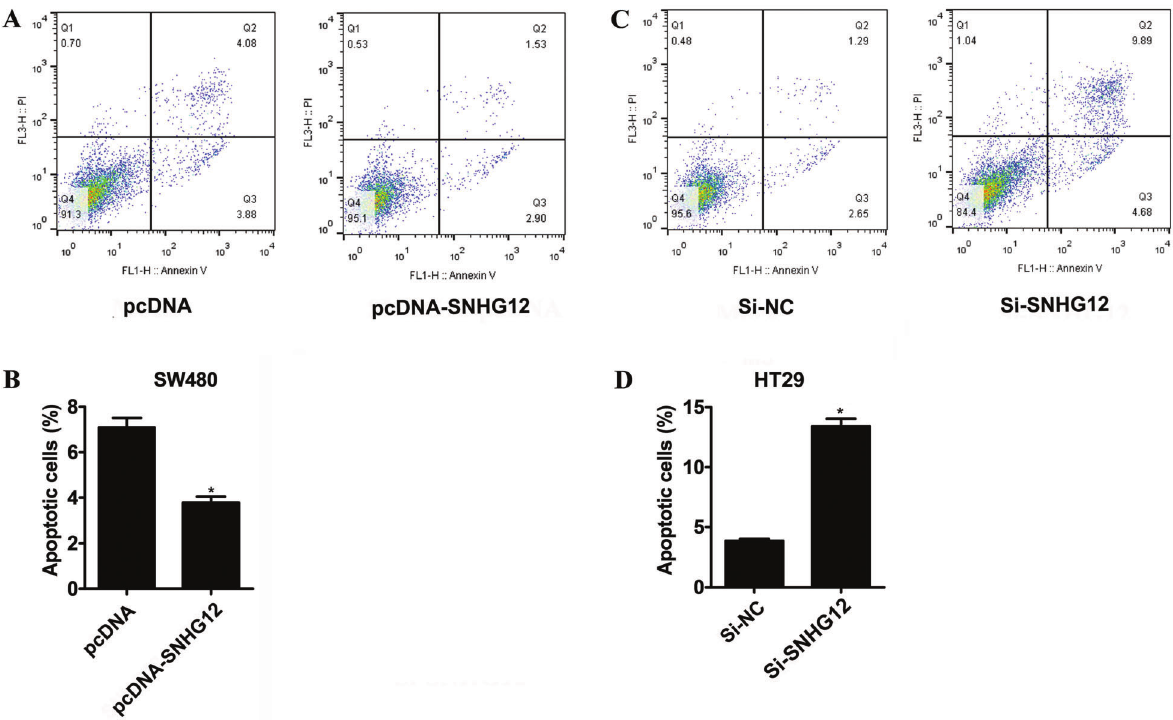
Figure 4. Flow cytometric analysis for cell cycle progression ( A ) and the corresponding statistical result ( B ) in SW480 cells transfected with pcDNA- SNHG12 and in HT29 cells transfected with si- SNHG12 ( C and D , respectively). Data are reported as means ± SD. *P o 0.01 vs control (Student ’ s t -test).